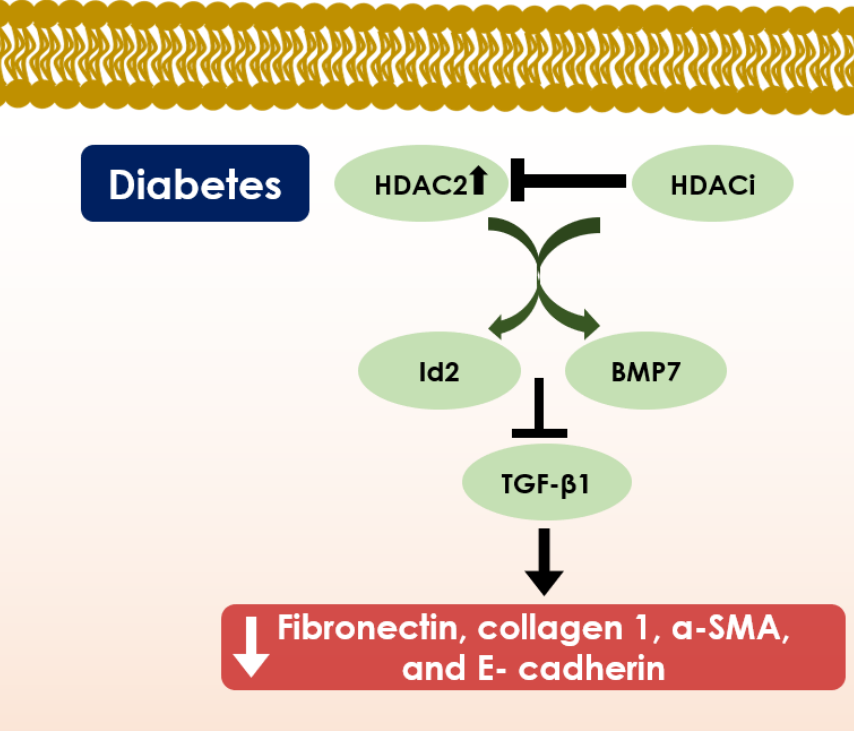
Figure 5. Schematic diagram showing the role of HDACs in diabetic nephropathy. HDAC2 inhibition by HDACi induces expression of DNA binding/differentiation 2 (Id2) and bone-morphogenic protein 7 (BMP7) that represses downstream TGF- β1 signalling and subsequently declines fibronectin, collagen 1, α - SMA, and E- cadherin expressions; and thereby, it provides protection either from diabetic nephropathy or nephromegaly.